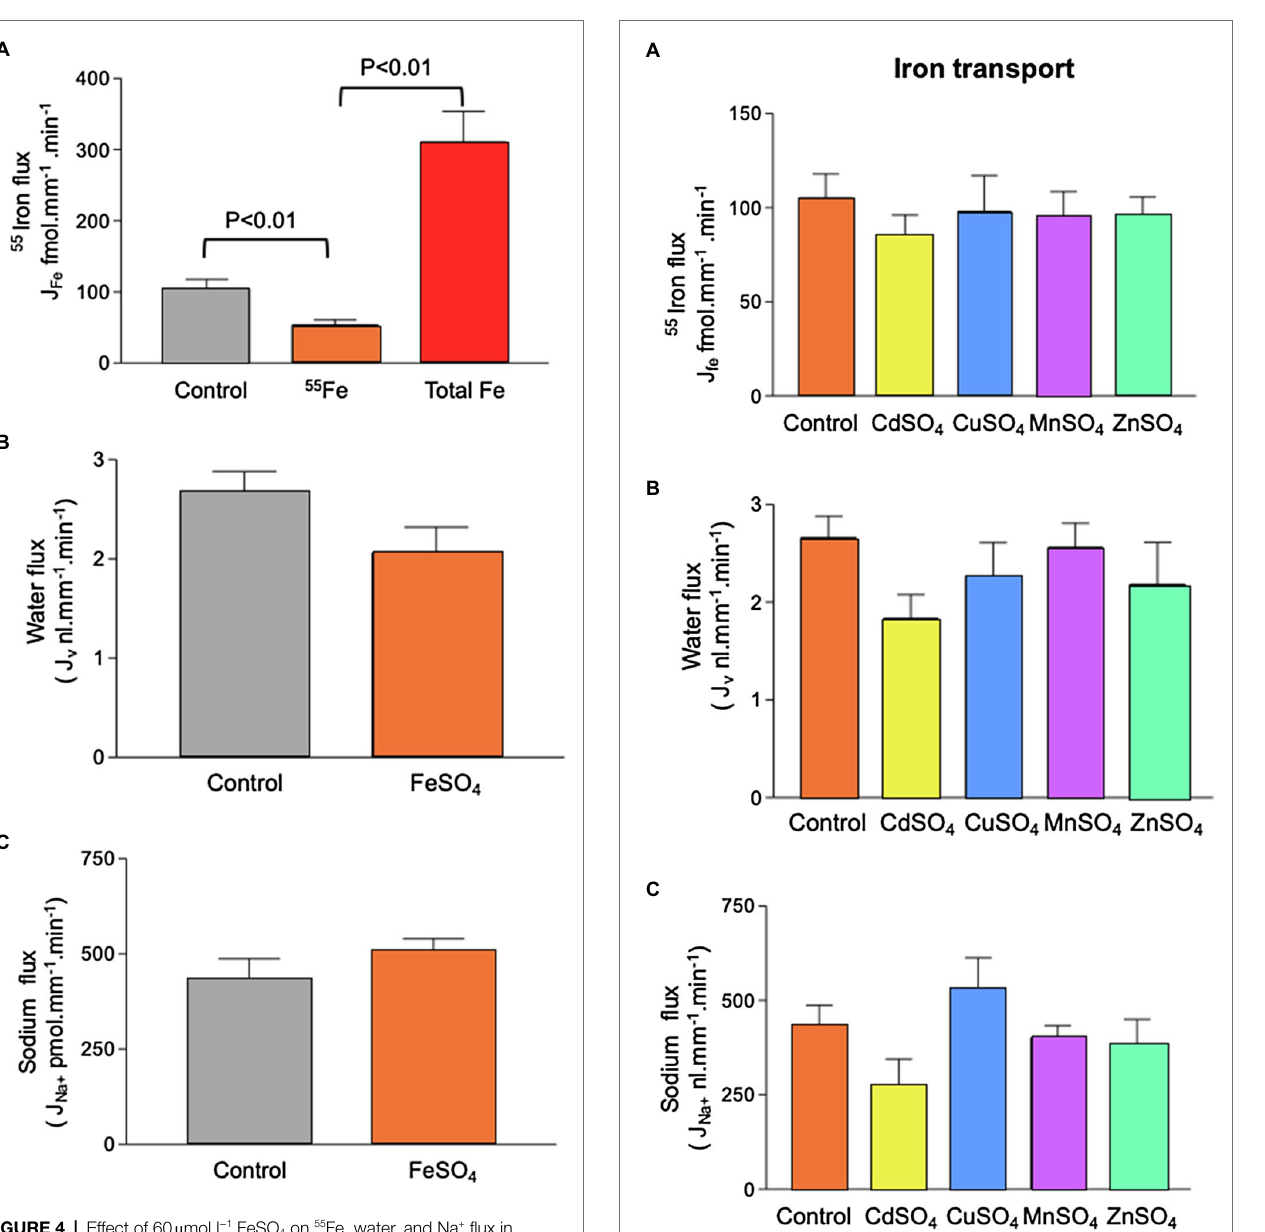
FIGURE 4 | Effect of 60 μ mol.l − 1 FeSO 4 on 55 Fe, water, and Na + flux in microperfused renal PCTs. Surface S2 PCTs were microperfused in vivo. (A) Addition of 60 μ mol.l − 1 FeSO 4 reduced 55 Fe flux from 105.2 ± 12.7 fmol. mm − 1 .min − 1 to 53.5 ± 7.5 fmol.mm − 1 .min − 1 ( n = 11; p < 0.01). Recalculating the molar activity of 55 Fe to take into account the addition of 60 μ mol.l − 1 iron denoted “Total Fe” revealed that iron transport as a whole increased to 310.5±43.4 fmol.mm − 1 .min − 1 ( n = 11; p < 0.01). ( B) Mean water flux was reduced by inclusion of 60 μ mol.l − 1 FeSO 4 from 2.7 ± 0.2 to 2.1 ± 0.3 nl.mm − 1 . min − 1 ( n = 11), but the observed reduction was not statistically significant at p,0.5 level. (C) Sodium flux by microperfused PCT (428.6 ± 57.2; n = 19. Addition of 60 μ mol.l − 1 FeSO 4 gave a mean value of 514.80 ± 28.6 nmol.mm − 1 . min − 1 ; n = 11).